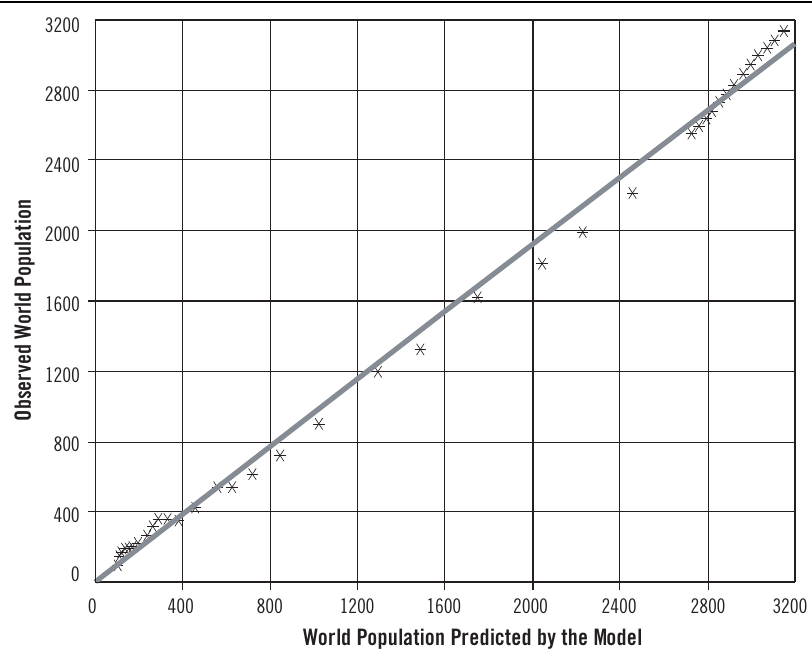
Figure 3 – Predicted and Observed Dynamics of World Population Growth, Figure 4 – Correlation between Predicted and Observed